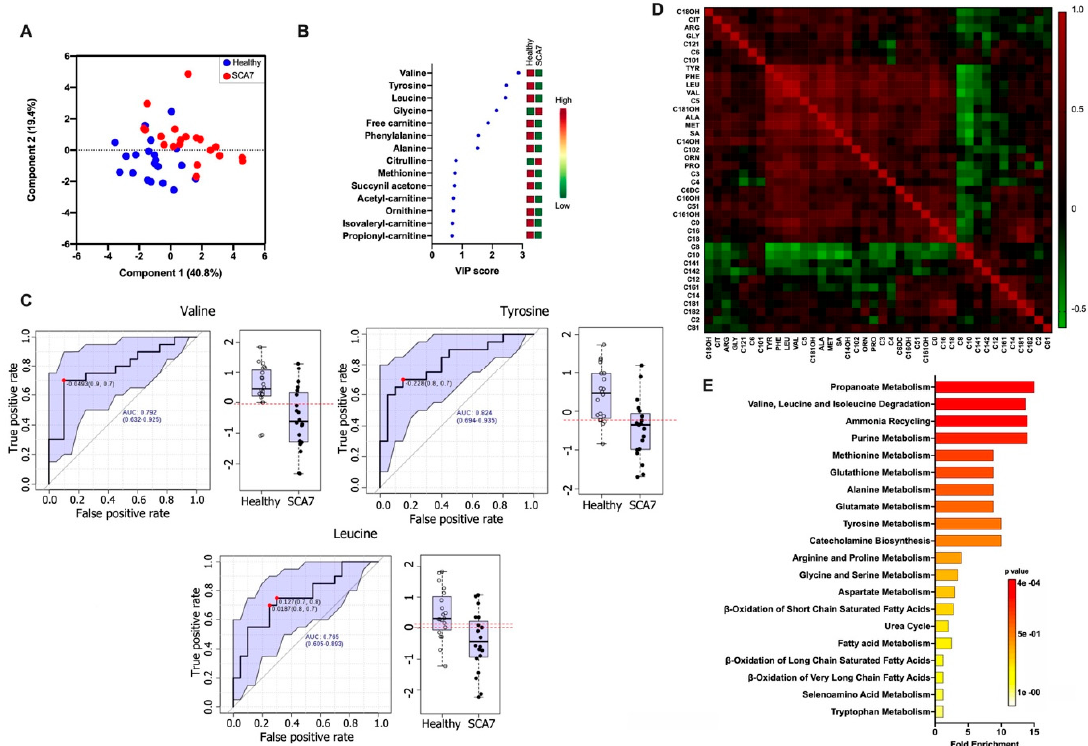
Figure 1 . ( A ) Partial Least Squares Discriminant Analysis (PLS-DA) plot showing separation between groups; healthy group (blue circles) and SCA7 group (red circles). The explained variances are shown in brackets; ( B ) Variable Importance in Projection (VIP) analysis represents the relative contribution of metabolites to the variance between healthy controls and SCA7 patients. A high VIP score indicates a great contribution of the metabolites to the group separation. The green and red boxes on the right indicate whether metabolite concentration is increased (red) or decreased (green); ( C ) Receiver Operating Characteristics (ROC) curves of Valine, Tyrosine, and Leucine. The sensitivity is plotted on the y-axis, and the specificity is on the x-axis. The Area Under the Curve (AUC) is in blue. The right image is a boxplot of the two groups within the dataset. A horizontal red indicates the optimal cutoff; ( D ) Unsupervised clustering of Correlation heatmap; red and green colors indicate increased and decreased correlation, respectively. ( E ) Enrichment analysis using Metabolite Set Enrichment Analysis (MSEA) for metabolic pathways in SCA7.